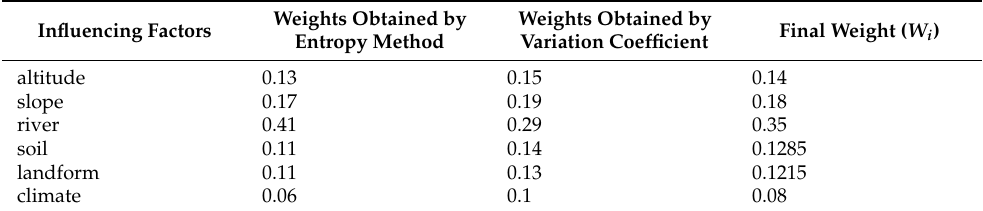
Table 9. Weights of factors affecting settlement